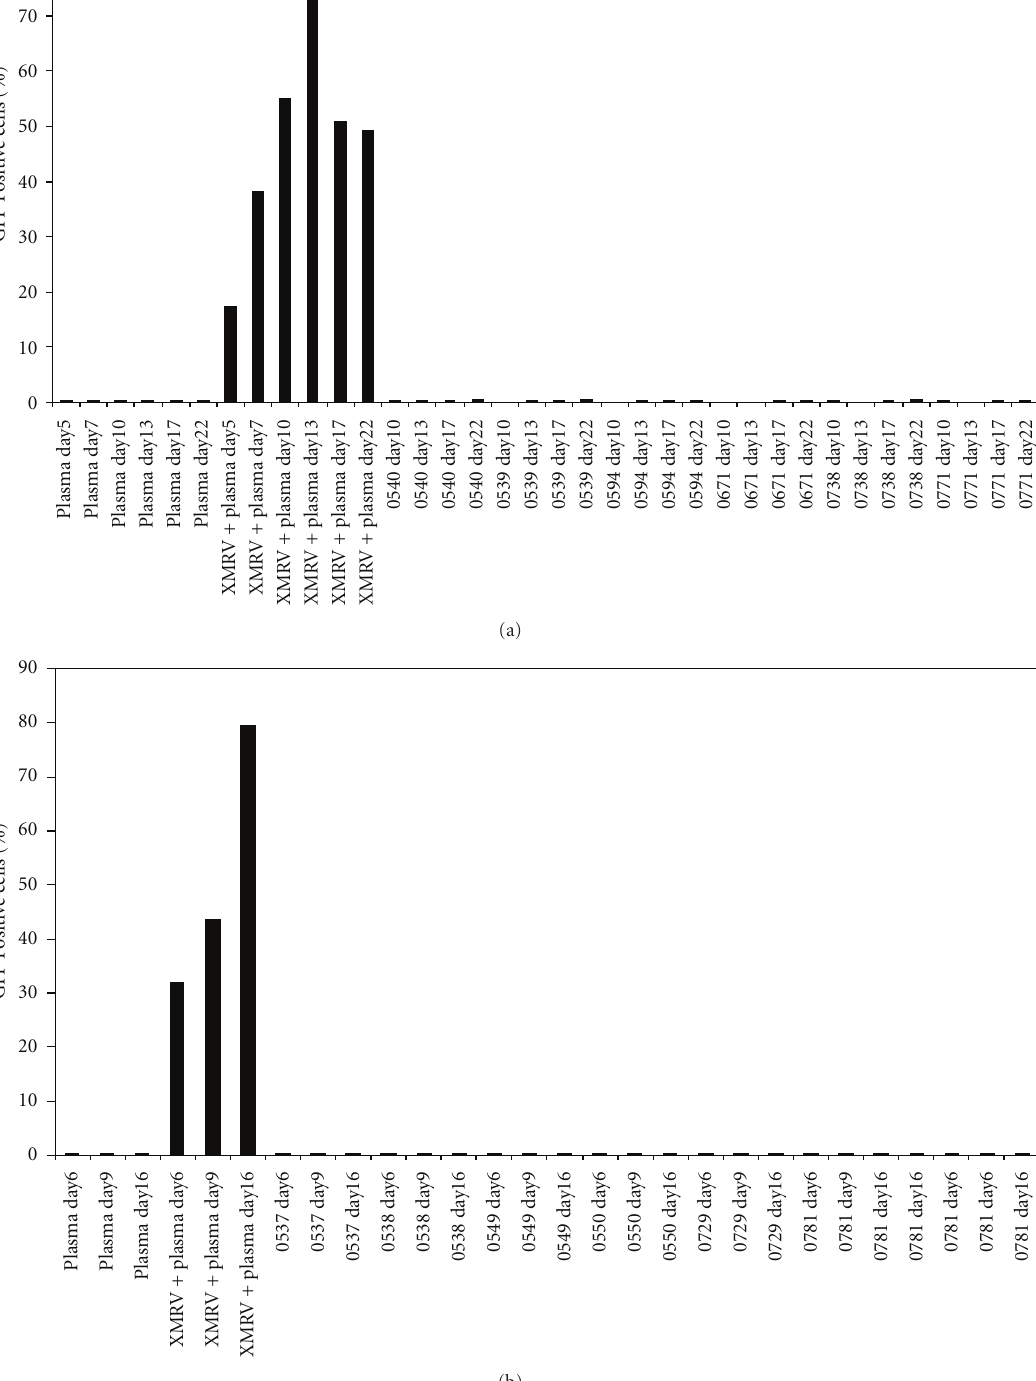
Figure 3: Testing plasma samples from prostate cancer patients for replication competent XMRV. Twelve samples were blinded as to their X-SCA and ELISA results and were tested for replicating virus using the DERSE.L-iG-P assay in two separate experiments. Six samples were tested in experiment 1 at passages 10, 13, 17, and 22 (a). All passages were negative for XMRV while virus was recovered from the positive control samples (10 7 copies of XMRV from 22Rv1 cells spiked into human plasma). Six additional samples were tested in experiment 2 at passages 6, 9, and 16 (b). All passages were negative for XMRV while virus was recovered from the positive control